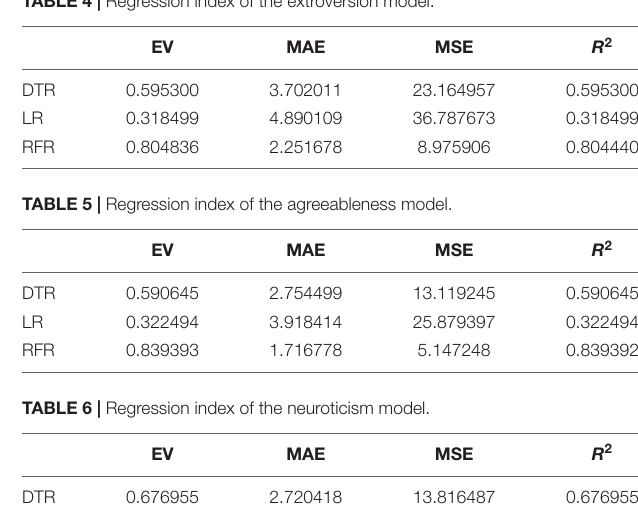
TABLE 4 | Regression index of the extroversion model.